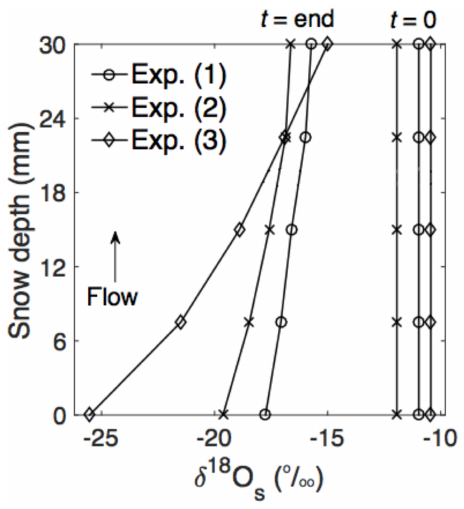
Figure 3. Spatial isotopic composition of δ 18 O of the snow sample at the beginning ( t = 0) and at the end ( t = end) for each experi- ment. The air entered at z = 0mm and exited at z = 30mm. Exp. (1) corresponds to the isothermal conditions Exp. (2) to air warming and Exp. (3) to air cooling in the snow